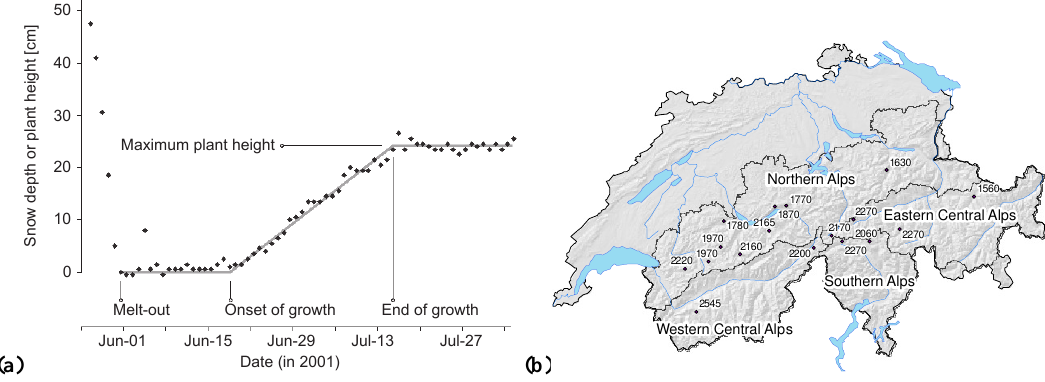
Figure 1 Fig. 1. (a) The ultrasonic snow depth sensor tracks vegetation height during summer (black dots) here shown for the site Tujetsch (2270ma.s.l.). From these measurements, melt out, onset of growth and maximum plant height (denoted as “plant height” throughout the text) can be determined. (b) Map of Switzerland and the locations of the IMIS snow stations with elevation and the four selected biogeographic regions for the simulations with high resolution climate data (figures modified from Jonas et al., 2008). from different stations and years (for details see Jonas